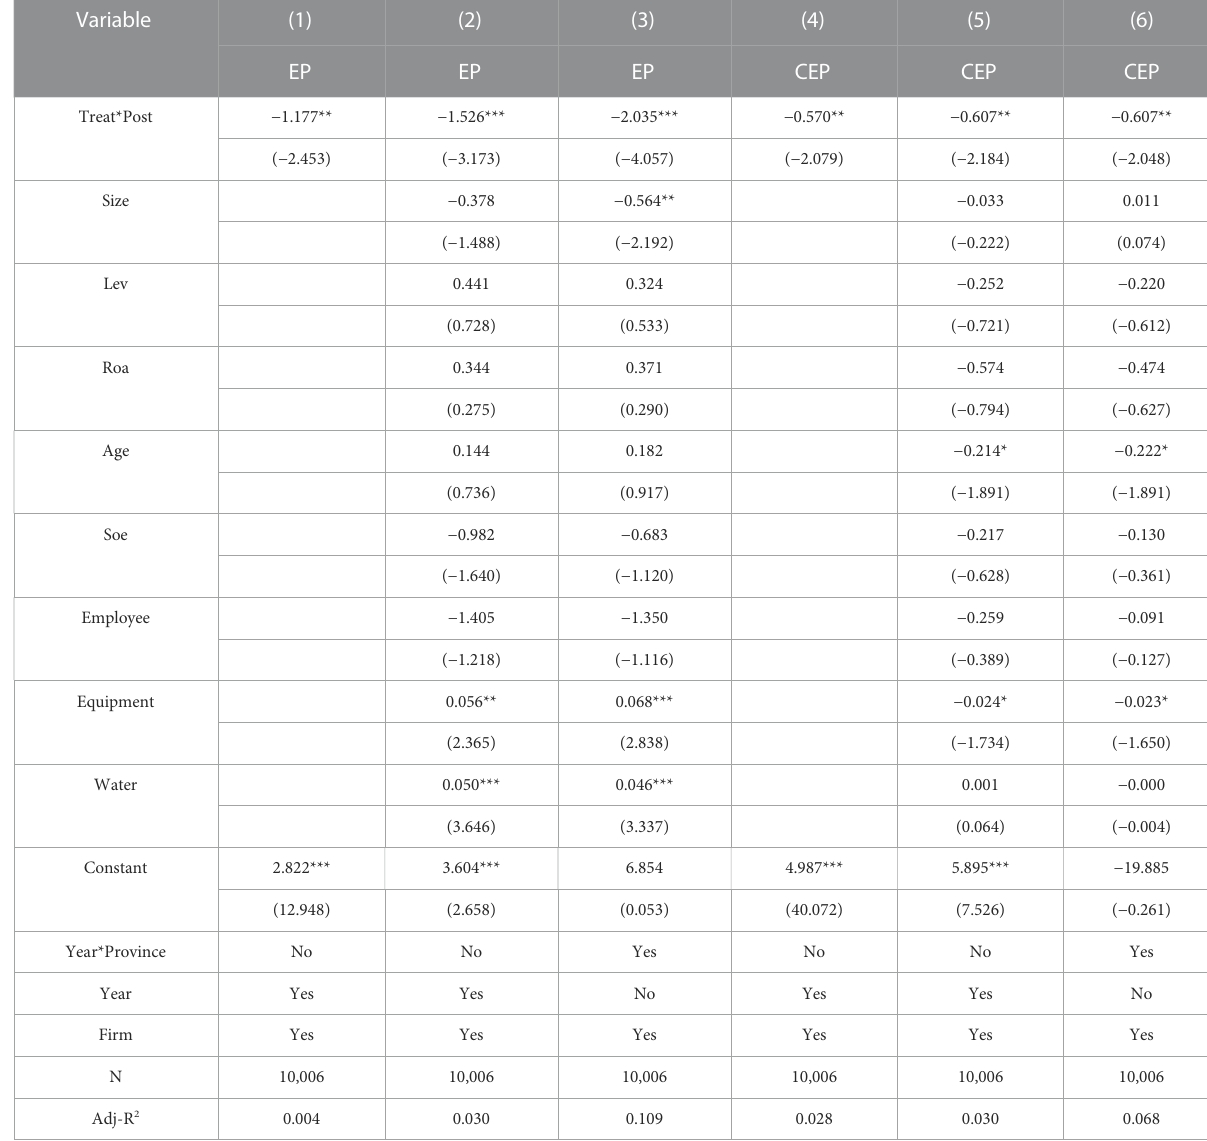
TABLE 3 Baseline regression results.